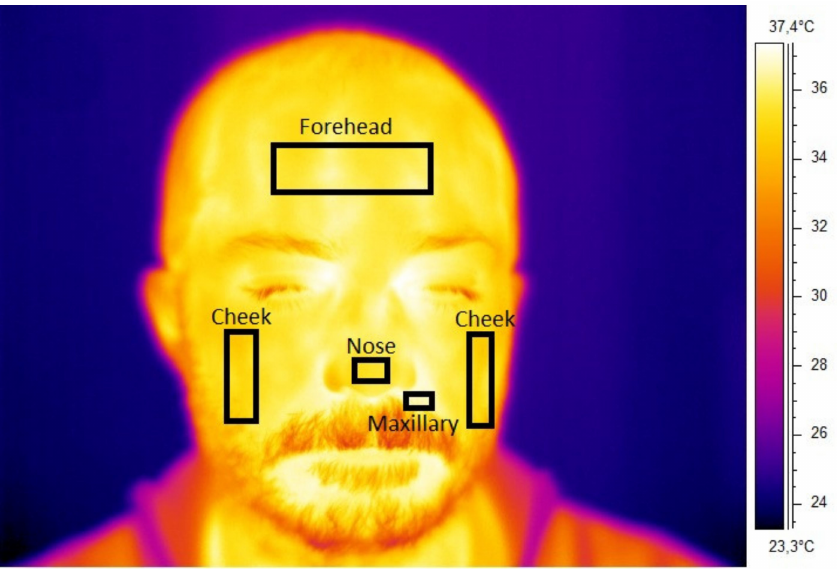
Figure 2. Thermal IR images with marked ROIs (black